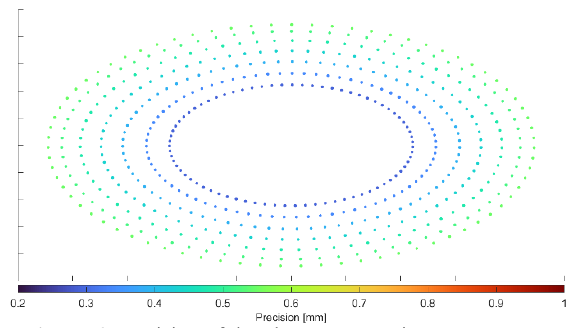
Figure 6 . Precision of the photogrammetric measurement system.